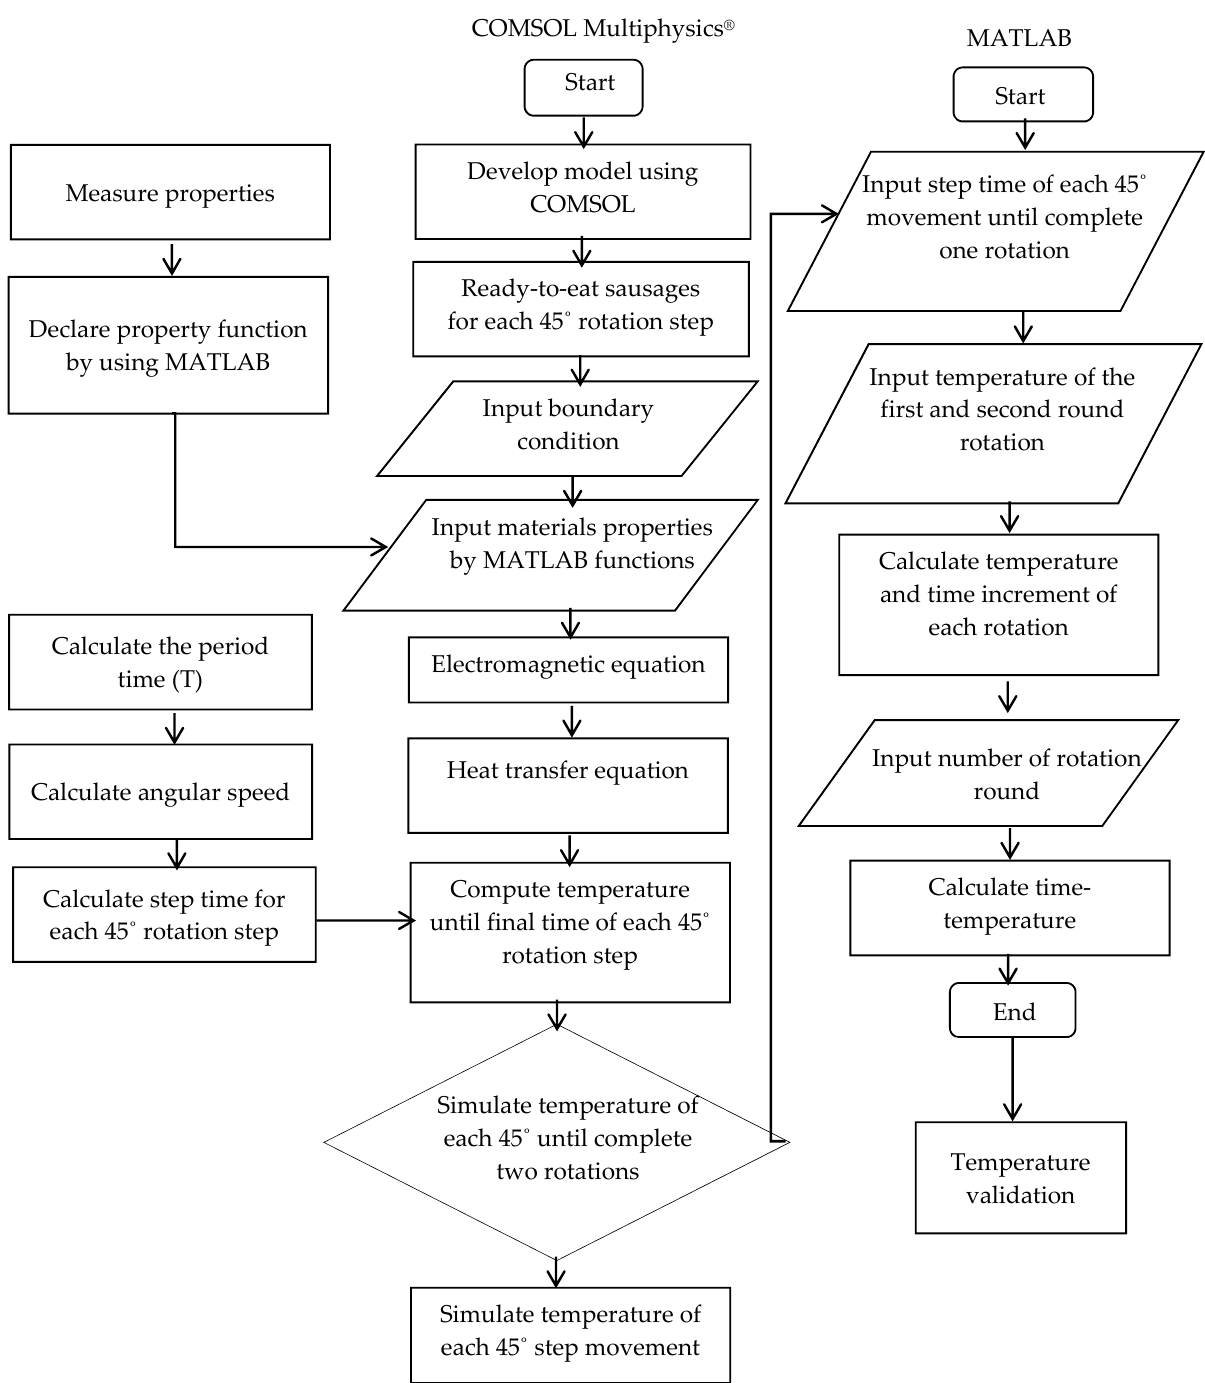
Figure 5. Flow diagram of COMSOL Multiphysics ® software in combination with